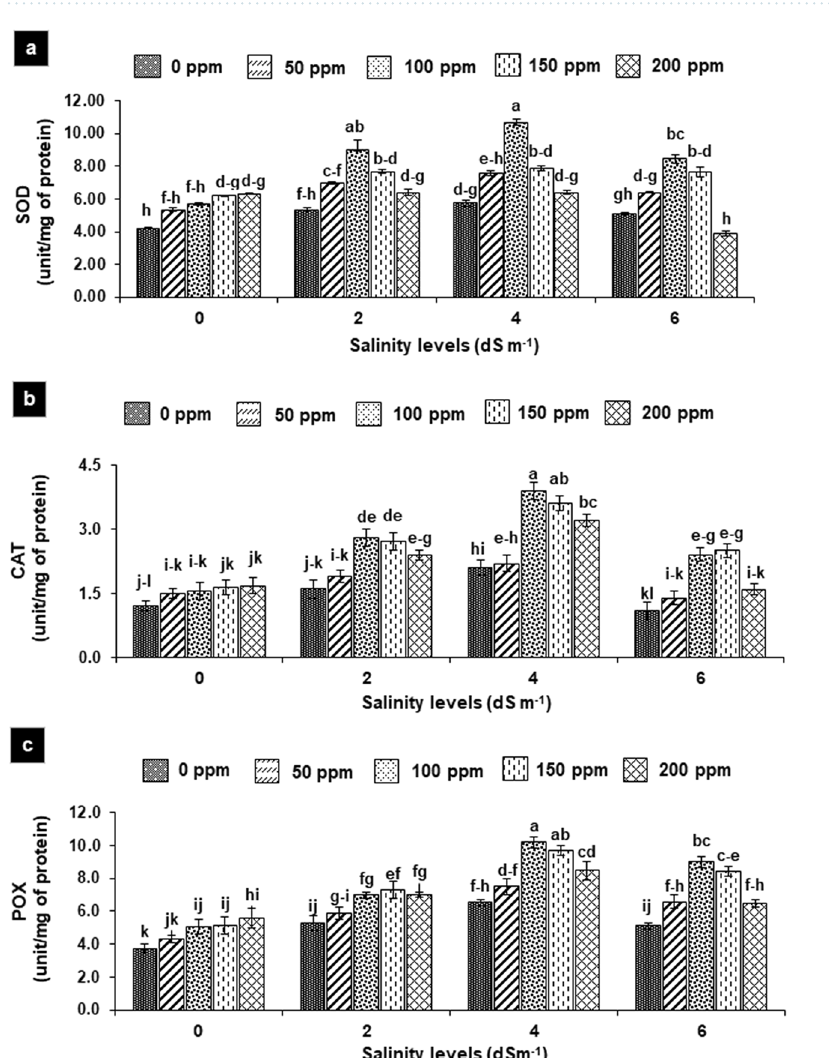
Figure 5. (a – c) Effects of foliar application of salicylic acid on activity SOD ( a ), CAT ( b ) and POX ( c ) in Gladiolus grandiflorus irrigated with saline water. Vertical bars show standard errors of means of three replicates. Different letters indicate significant differences (P < 0.05) according to LSD test; the same letter indicates no significant differences between the